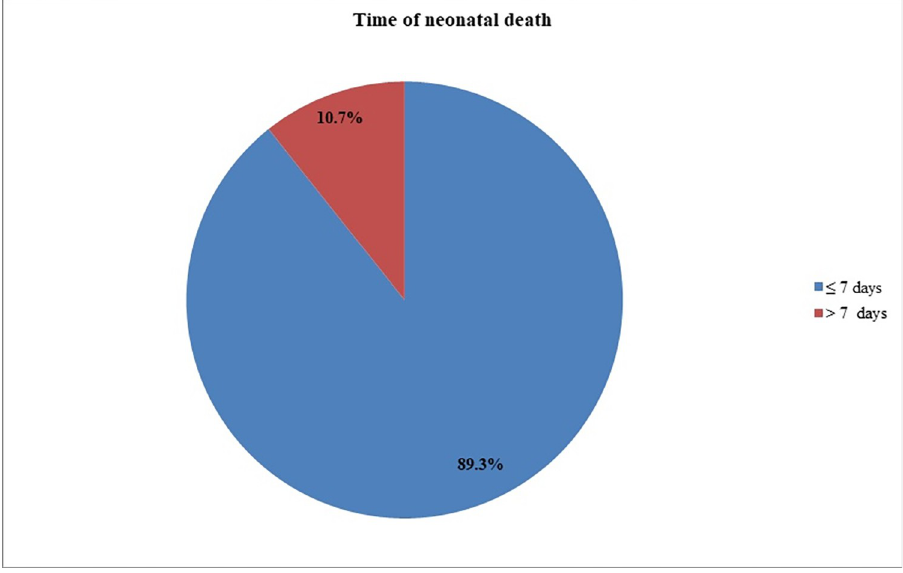
Fig 3. The occurrence of neonatal death among asphyxiated newborns admitted to the NICU of DCSH, Amhara region, Northeast Ethiopia (N = 378).